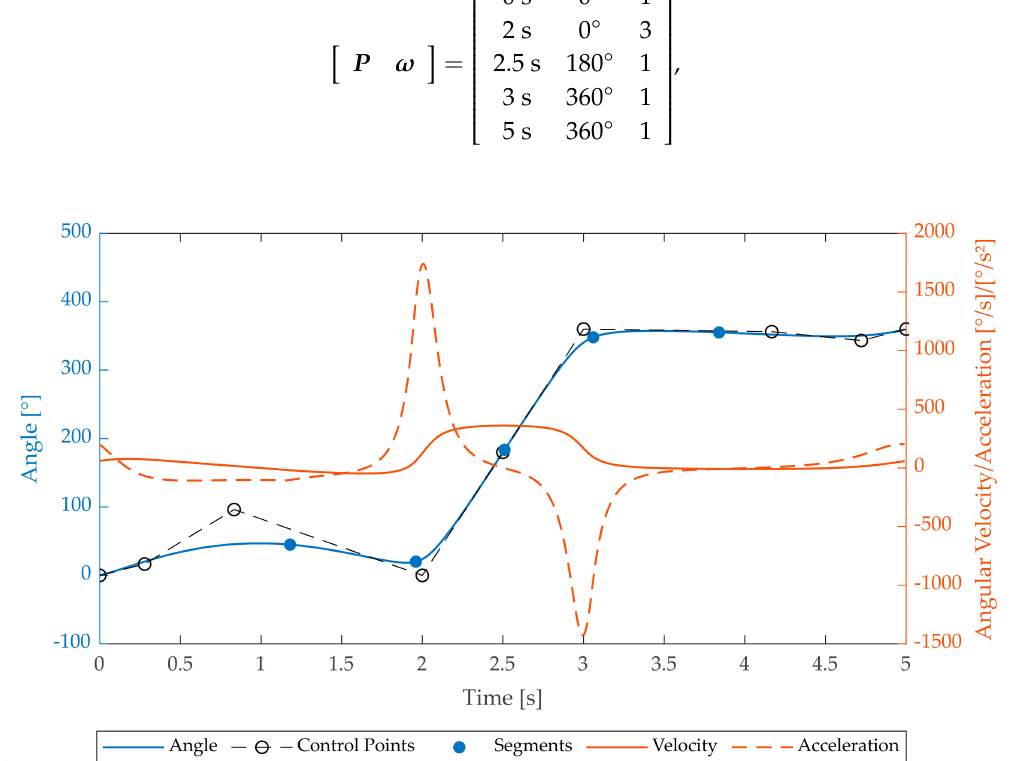
Figure 3. Example of a periodic NURBS curve with v = 60 ◦ / s and a = 200 ◦ / s 2 by insertion of extra control points at the beginning and at the end of the